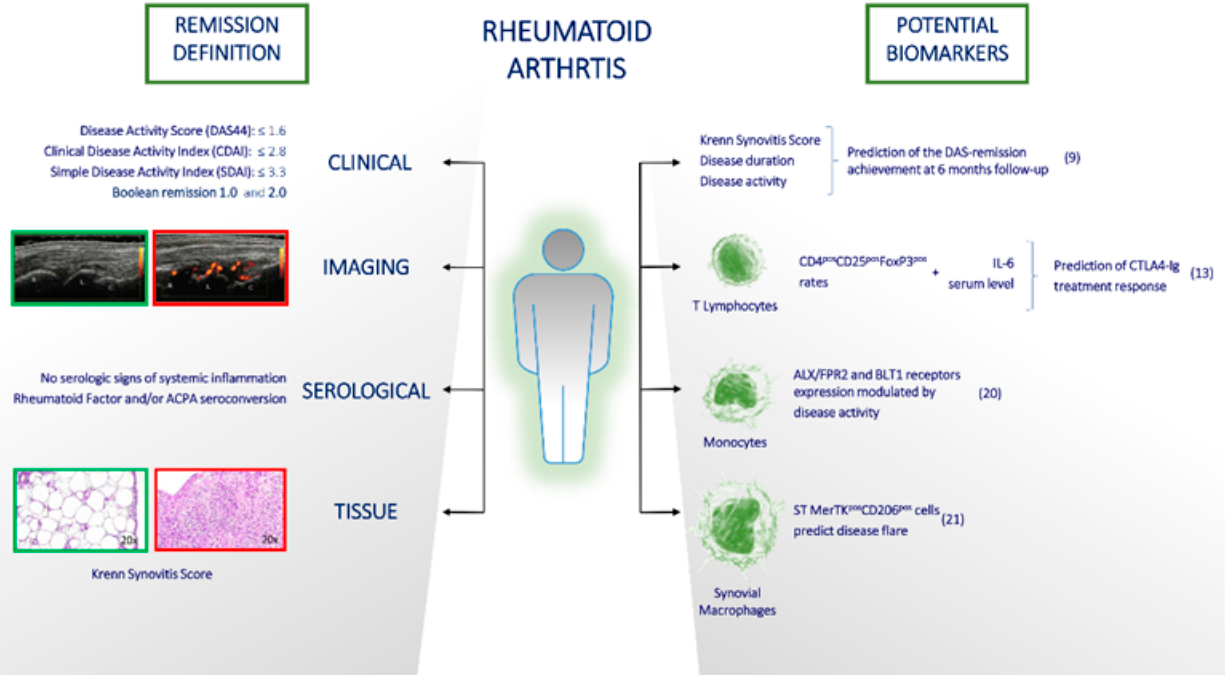
Figure 1. How remission status in Rheumatoid Arthritis is de fi ned (left section) and what are the next potential biomarkers (right section) which might help in the management of this disease.